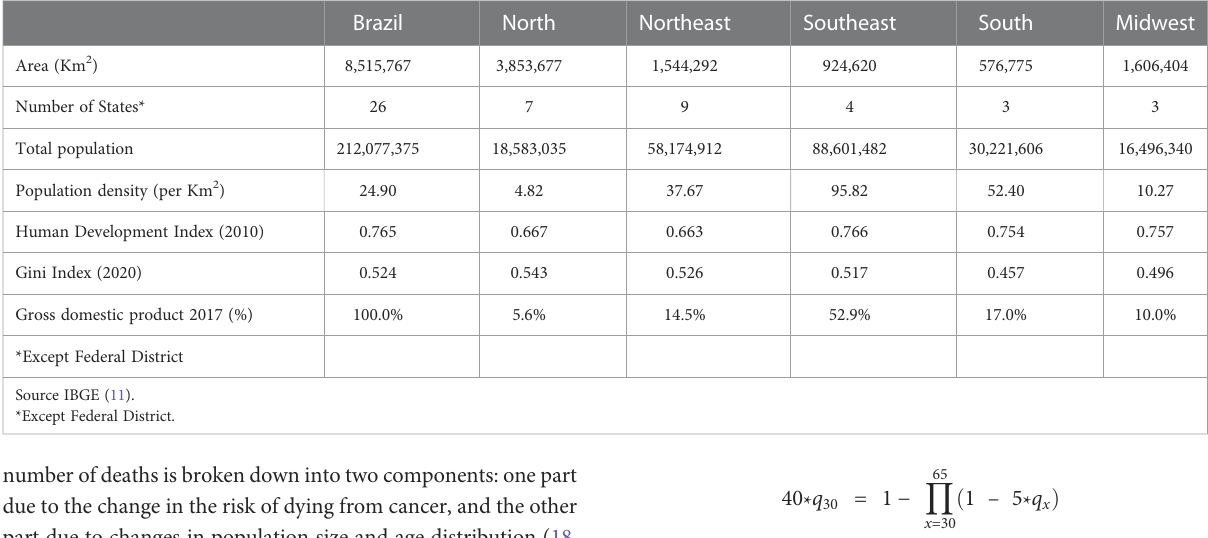
TABLE 1 Sociodemographic characteristics, Brazil and geographical